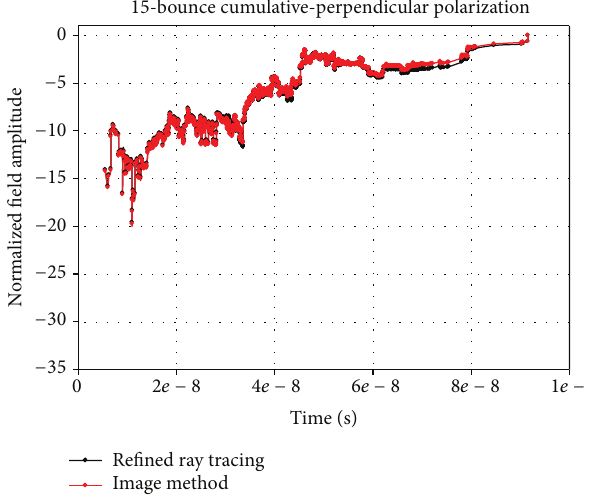
Figure2:RFfieldbuild-upatthereceiverinsidealossycuboidusing image method and refined ray tracing method.